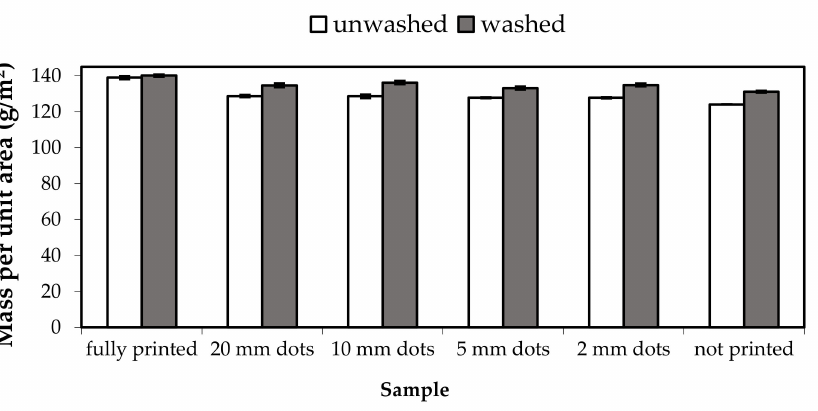
Figure 4. Mass per unit area of sample printed without pattern, samples printed by pattern (dots) and of not printed